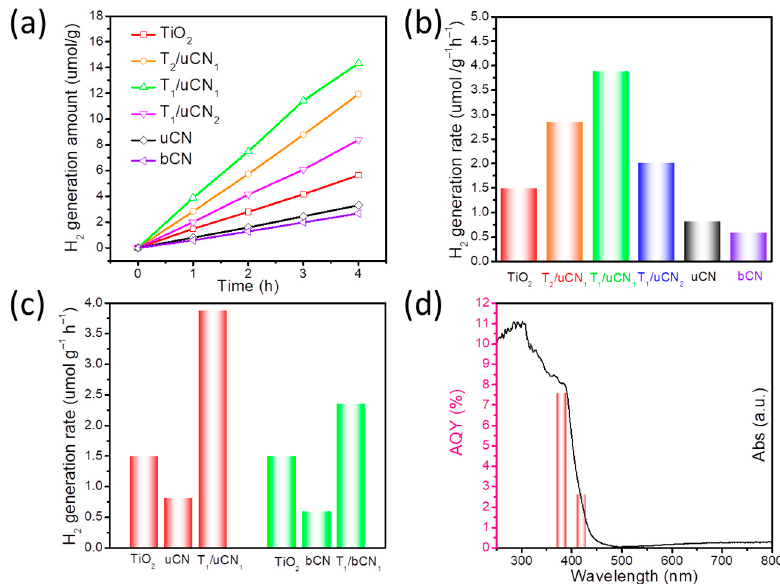
Figure 5. ( a ) Photocatalytic hydrogen generation on bCN, TiO 2 and T/uCN samples during four hours under simulated solar light illumination. ( b ) Photocatalytic hydrogen peroxide generation rate of bCN, TiO 2 and T/uCN samples. ( c ) H 2 production rate contrast between T 1 /uCN 1 and T 1 /bCN 1 . ( d ) Wavelength-dependent AQY of T 1 /uCN 1 .